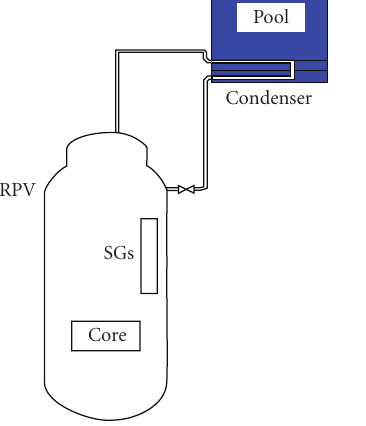
Figure 1: Passive pool heat removal system for a prototypical inte- grated